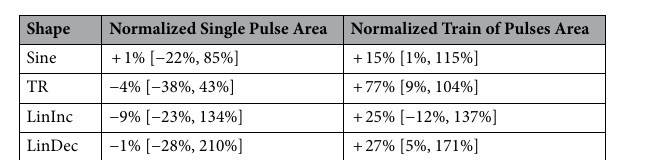
Figure 4. The sensations reported following stimulation by train of 15 pulses at 30 Hz were reported and superimposed on the same drawing. As in the case of single-pulse stimulation, it can be seen that the different waveforms have similar points of origin, although the areas of sensations are slightly different, and tend to be larger for non-rectangular waveforms. The increased delivered charge induced by the pulse train also results in sensations in a greater portion of the hand affected by the stimulation, indicating that more neural fibers have been affected. Radar plots have been graphed inside the range of the sensation with the maximum correspondences. In this case, moreover, the induced sensations are moving towards vibrational sensations, though for linear ramps the electrical sensations are still more predominant.